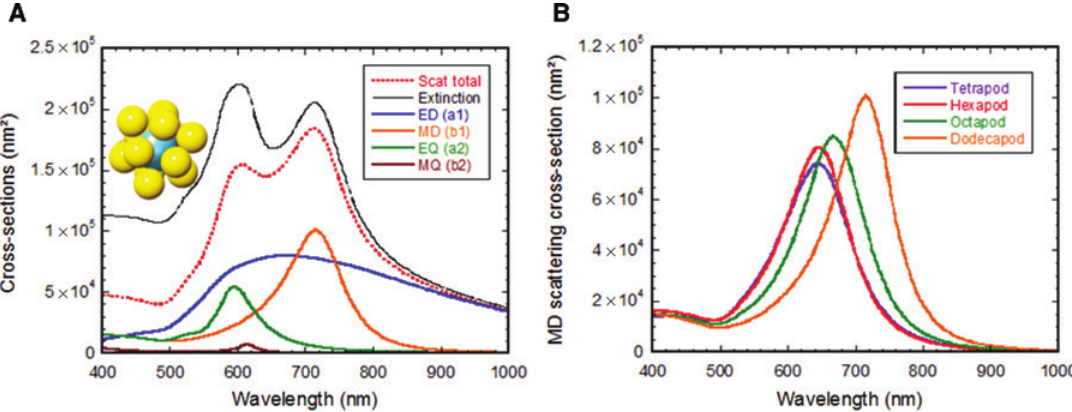
Figure 2: Simulated optical properties of the dodecapod and comparison with other multipods. (A) Extinction and scattering cross-sections of a dodecapod in water. The radii of the silica core and gold satellites are 50 and 40 nm, respectively. The scattering is essentially dominated by the three contributions of ED, MD, and EQ. (B) MD scattering cross-section computed for the four N-pods of Figure 1A–D. The radii R ( N ) of the satellites are 57.7, 50.4, 45.8, and 40 nm for N = 4, 6, 8, 12, respectively, to ensure a constant volume of gold N .4/3 π R ( N ) 3